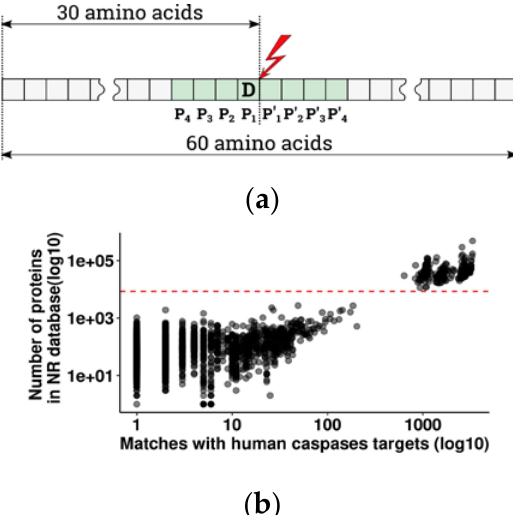
Figure 1. Selecting orthologous targets and representative proteomes. ( a ) Scheme of the 60 amino acid query sequences for the pBLAST search to identify human apoptotic caspase cleavage site orthologs. P4 – P4’: positions of amino acids within the cleavage site. D: key aspartate in the P1 position. Red lightning: scissile bond between P1 and P1’ amino acids. Green elements: caspase cleavage site. ( b ) Distribution of species by number of sequenced proteins in a non-redundant database and number of matches with human caspase cleavage sites. Each point corresponds to one species. The group above the red dashed line embraces species with well characterized proteomes. The red dashed line represents the threshold for the number of annotated proteins used to separate species with a well characterized proteome (log10(total N of proteins) > 3.9, or total N of proteins > 8000).